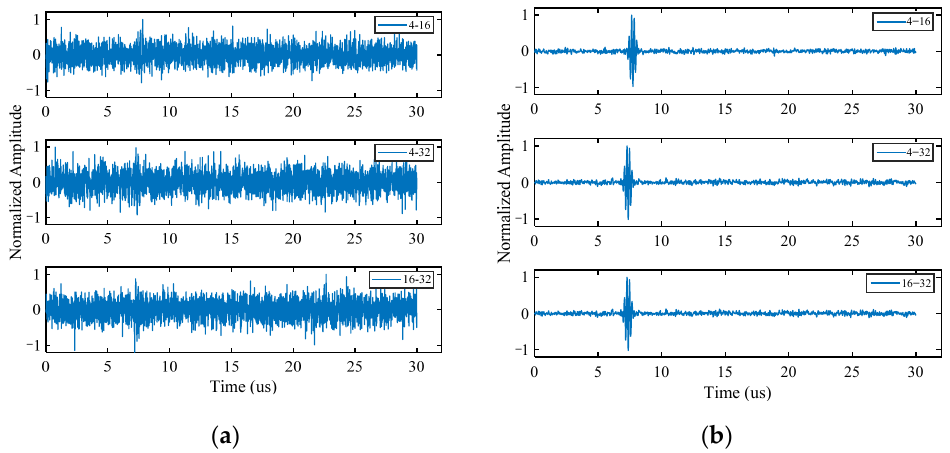
Figure 5. Time domain waveforms of simulated signals. ( a ) Before noise reduction; ( b ) after noise reduction.